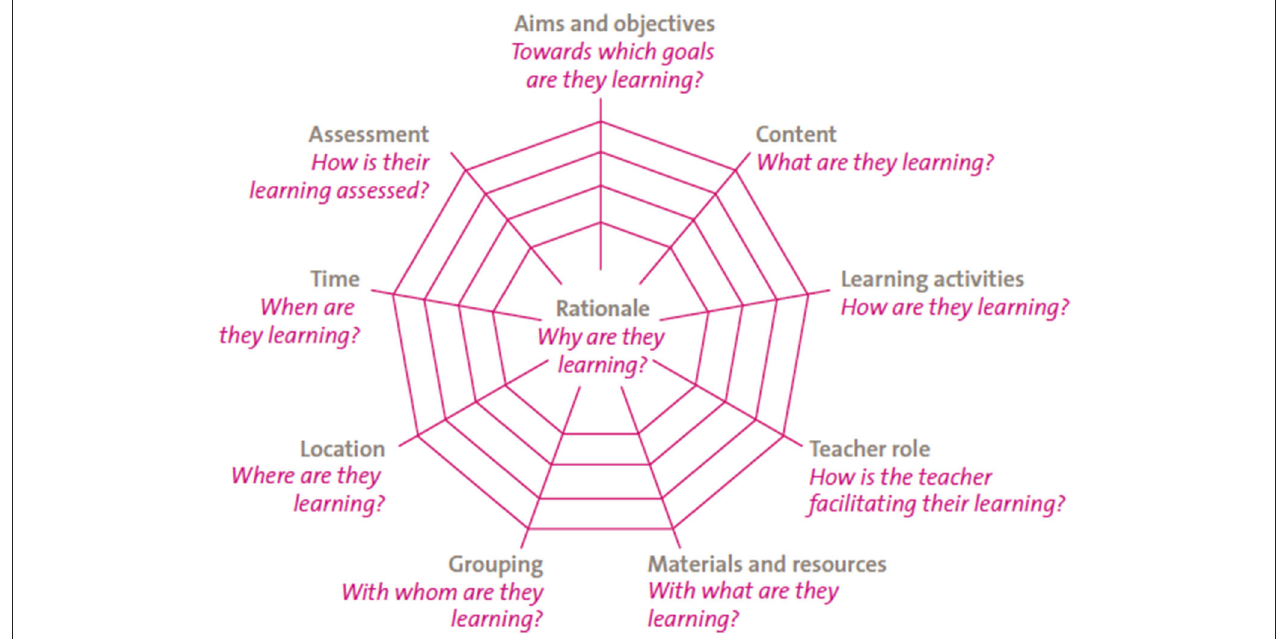
FIGURE 1 | van den Akker’s (2013) curriculum spider web. Source: van den Akker, “Curricular development research as a specimen of education design research" in Educational Design Research, 2013. Image used with permission from the author and the publisher, SLO.